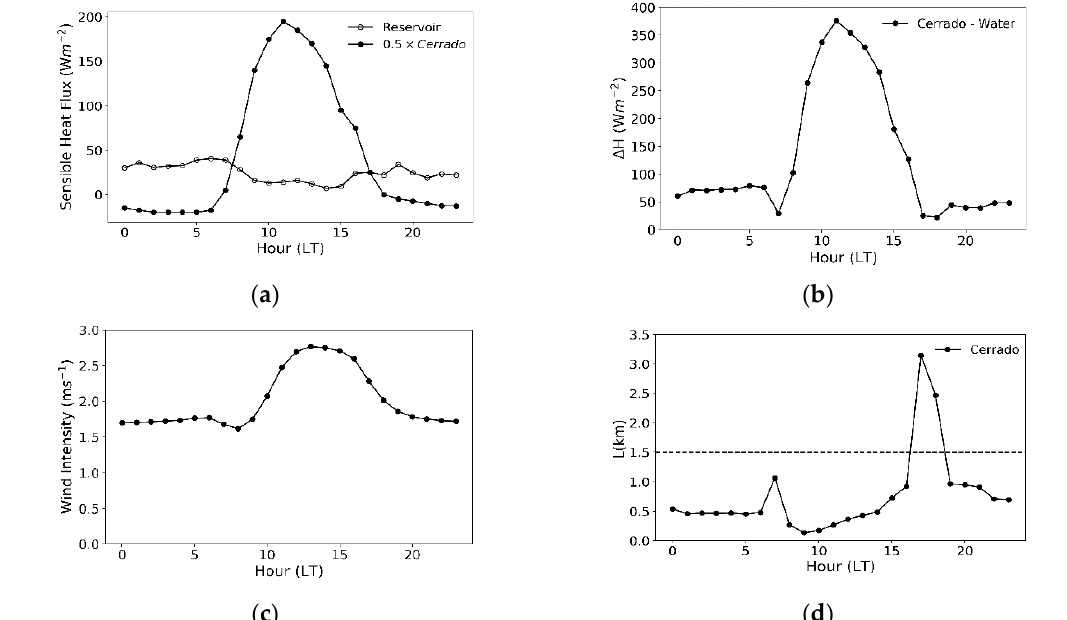
Figure 6. ( a ) Daily variability of sensible fluxes (H) as observed at a typical central Brazilian Cerrado area (solid line, from Miranda et al. [43]) and central Brazilian reservoir (dash-dotted, from Lorenzzetti et al. [44]) during the dry season; ( b ) difference between H in the reservoir and its surroundings (solid line—cerrado); ( c ) diurnal variability of ambient wind speed, and ( d ) minimum reservoir width, L, necessary to create a closed circulation. The horizontal line in panel ( d ) indicates the typical width of the Serra da Mesa reservoir.